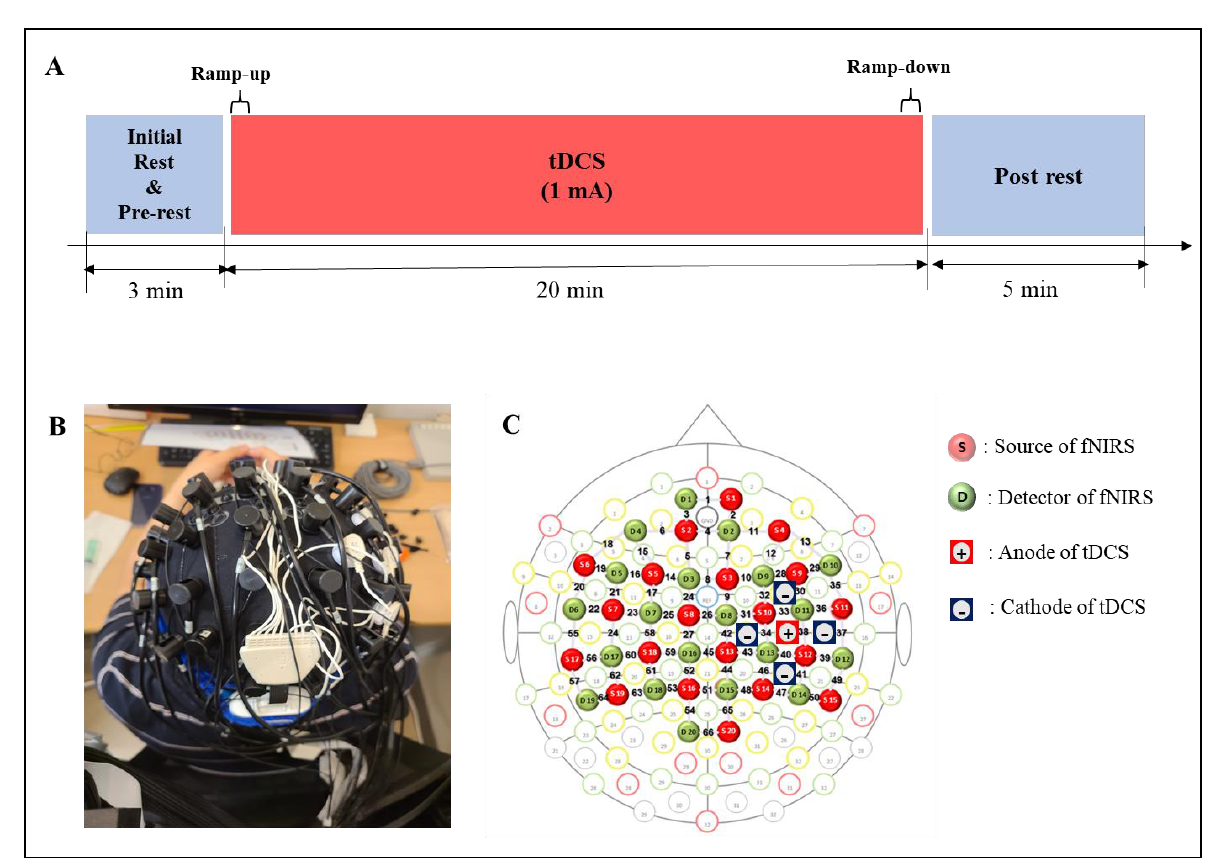
Figure 1. Experimental design. ( A ) Experimental conditions. ( B ) A head cap including the tDCS electrodes and fNIRS optodes. ( C ) Topography for tDCS electrodes and fNIRS optodes